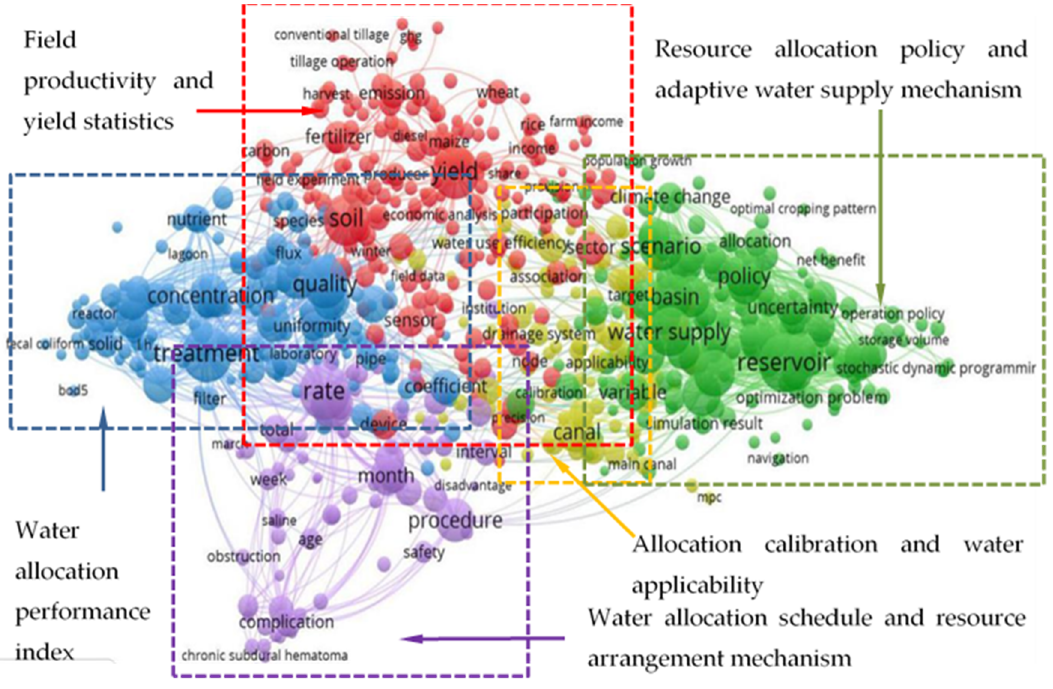
Figure 3. Bibliometrics diagram concerning the most-relevant keywords in the water allocation mechanism of precision irrigation, the focused topics and their mutual correlations investigated from 1999 − 2019 can be described and highlighted.